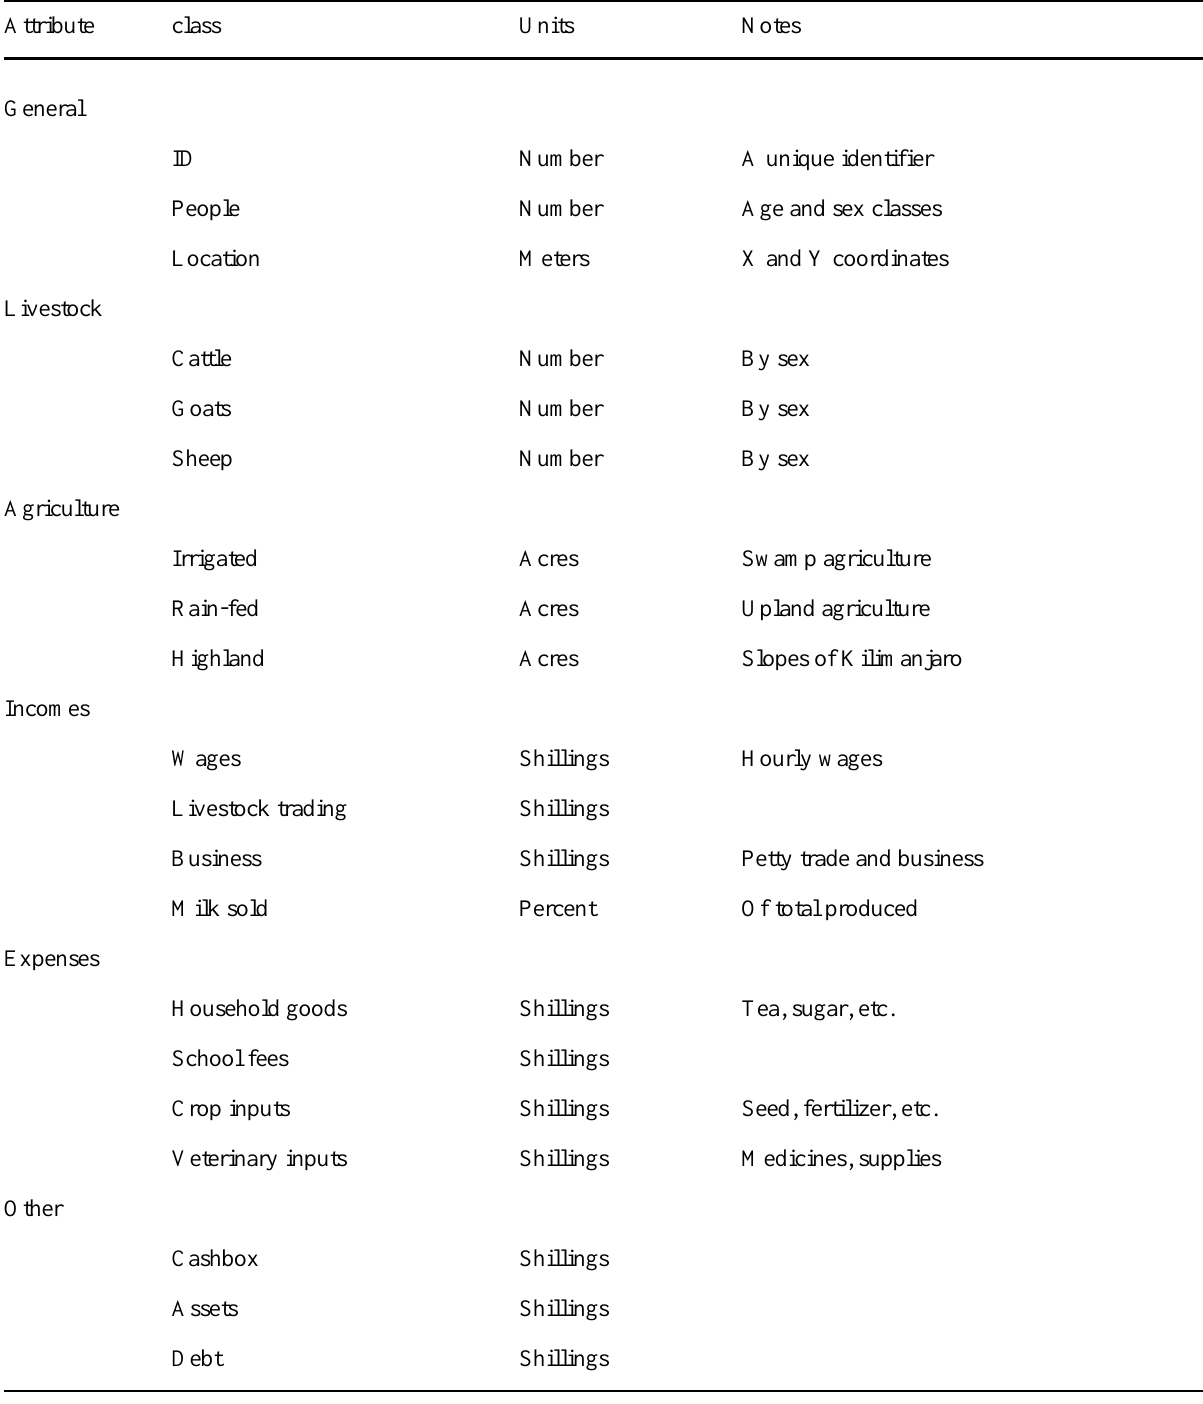
Table 1 . State variables of households represented in the DECUMA model. Variables are grouped into classes for clarity. These variables are assigned initial values only. Livestock populations, the cashbox, assets, and debts may change during a simulation. Milk income depends on the number of lactating cattle in the household herd. Other attributes of the household do not change during a